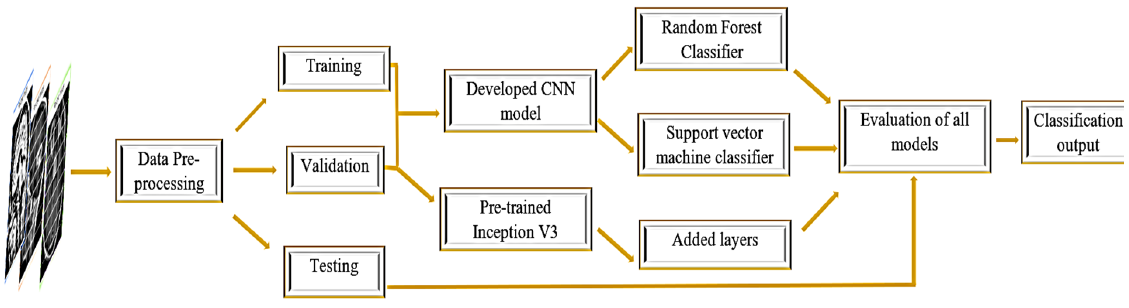
Fig. 1 The working flow of the proposed